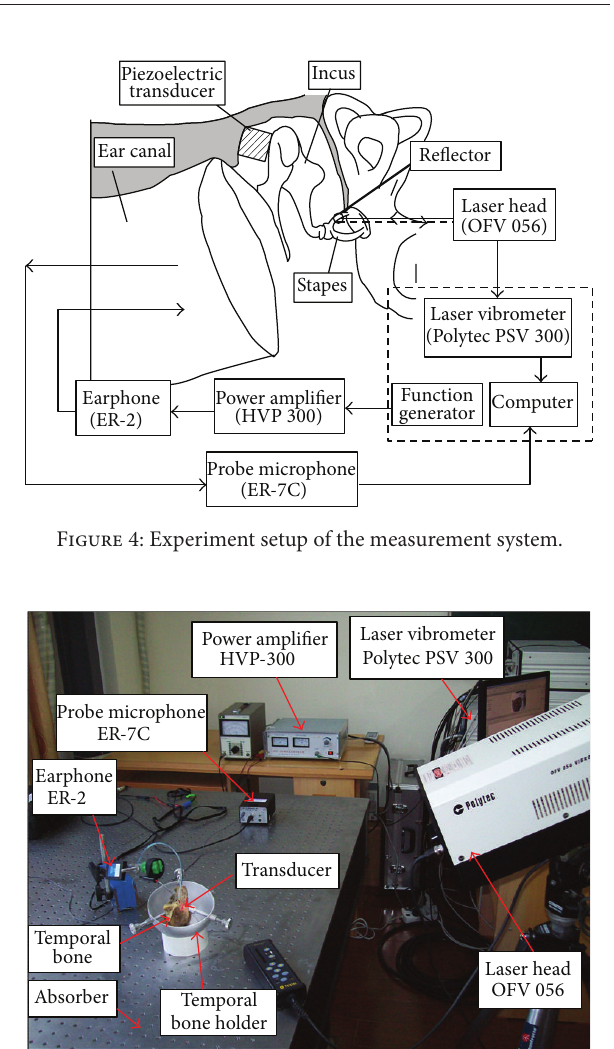
Figure 5: Picture of the temporal bone